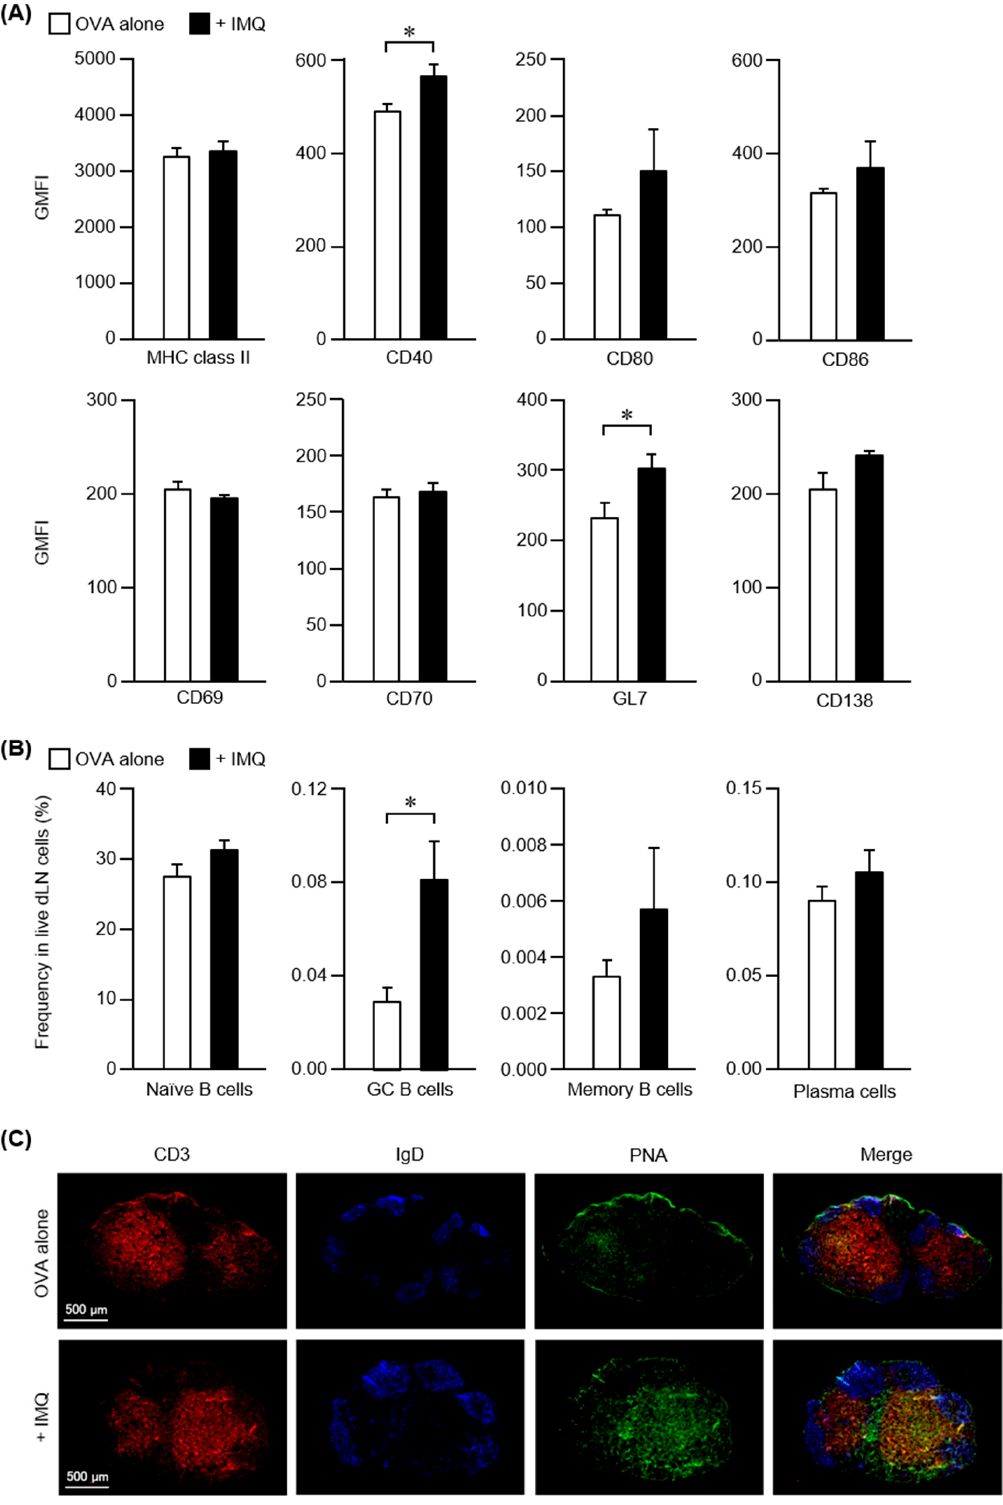
Figure 3. B cell activation and differentiation. C57BL/6 mice were immunized using the poke and patch method with OVA or OVA plus IMQ (50 μ g). Two weeks later, B cell activation and differentiation in the dLNs were analyzed by FCM. ( A ) The expression levels of MHC class II, CD40, CD80, CD86, CD69, CD70, GL7, and CD138 on B cells were analyzed by FCM and are presented as GMFIs. The data shown are expressed as the mean ± SE of the results from five (CD70, CD80, CD86, and GL7) or six (MHC class II, CD40, CD69, and CD138) mice (Welch’s t -test, * p < 0.05). “a.u.” means arbitrary unit. ( B ) B cells were divided into four subsets: naive B cells (CD19 + , IgD + ), GC B cells (CD19 + , IgD − , GL7 + , CD95 + ), memory B cells (CD19 + , IgD − , GL7 − , CD27 + ), and plasma cells (B220 − , IgD − , CD138 + ). The frequency of each population in the dLNs was analyzed by FCM. The data shown are expressed as the mean ± SE of the results from to five (naive, GC, and memory B cells) or six